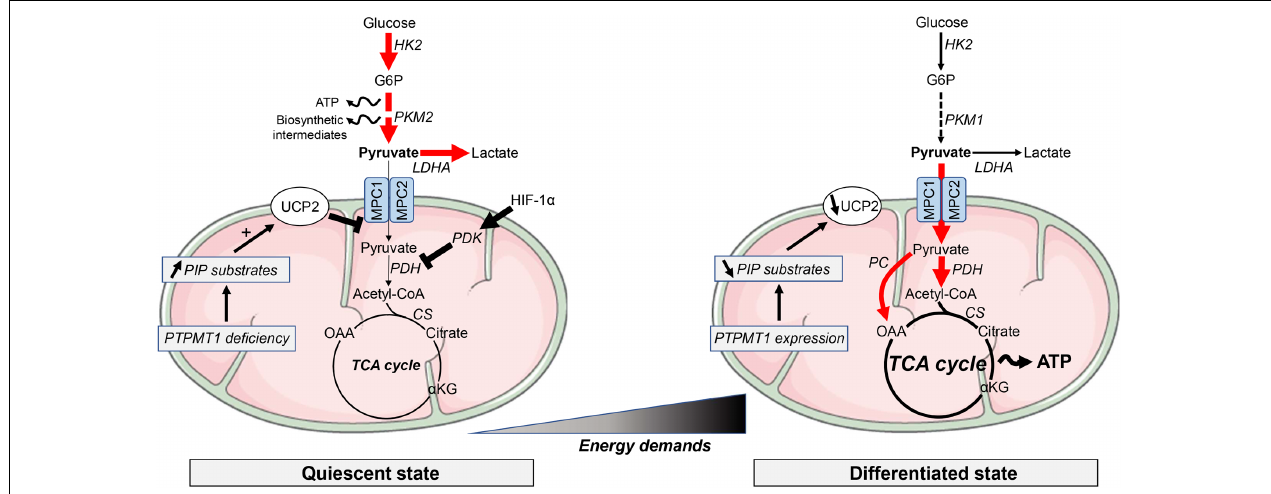
FIGURE 1 | Metabolic requirements in pluripotent stem cells and differentiated cells. Most of the quiescent stem cell populations rely on glycolysis to provide ATP and building blocks necessary for the synthesis of lipids, proteins or nucleotides. Along differentiation, energy metabolism shifts toward mitochondrial OXPHOS to support the increasing energy demands. Glycolysis-associated enzymes, such as hexokinase (HK), pyruvate kinase (PK) and lactate dehydrogenase A (LDHA), are highly expressed in PSCs. Pyruvate import into mitochondria is repressed by high expression of uncoupling protein 2 (UCP2). UCP2 is upregulated by accumulation of phosphatidylinositol phosphate (PIP) substrates following the downregulation of the mitochondrial phosphatase PTPMT1. α KG, α -ketoglutarate; ATP, adenosine triphosphate; CS, citrate synthase; G6P, glucose 6-phosphate; HIF, hypoxia-inducible factor; MPC, mitochondrial pyruvate carrier; PDH, pyruvate dehydrogenase; PDK, PDH kinase; OAA, oxaloacetate. Elevated metabolic pathways are indicated with bold